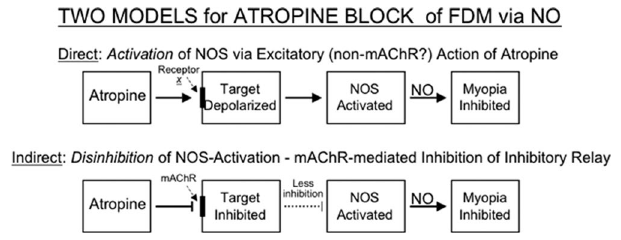
Figure 6. Two possible mechanisms for induction of NO synthesis by atropine, suggested by the results reported in this paper. TOP: In the direct pathway, atropine could cause excitation (depolarization) of a target cell; this would cause an increase in intracellular calcium, and possibly activation of nNOS or eNOS – thus leading to NO synthesis and release, and prevention of myopia. BOTTOM: In an indirect pathway, atropine could cause inhibition of a target cell that releases inhibitory transmitters – causing decreased release of neurotransmitter, and thus excitation of the cell that was being inhibited (disinhibition) – finally leading to an increase in intracellular calcium, activation of constitutively expressed nNOS or eNOS, induction of NO synthesis, and prevention of myopia. Each step could represent the overall function of more complex